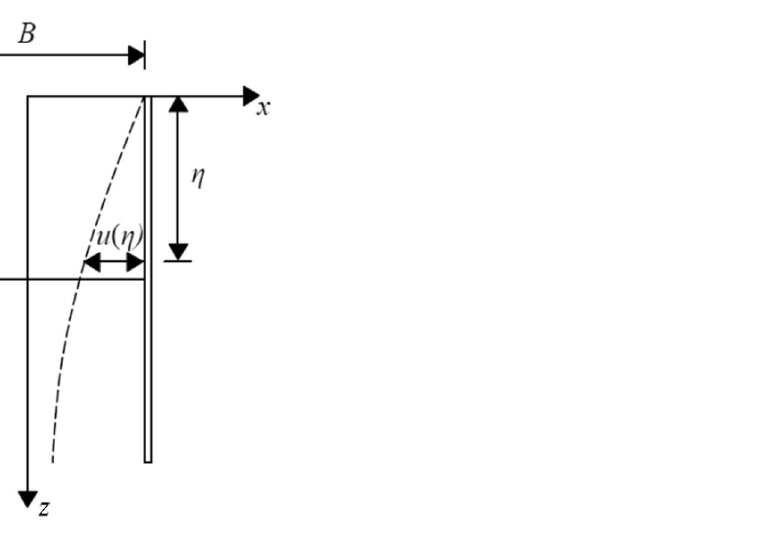
Figure 3. Calculation model of kick-in